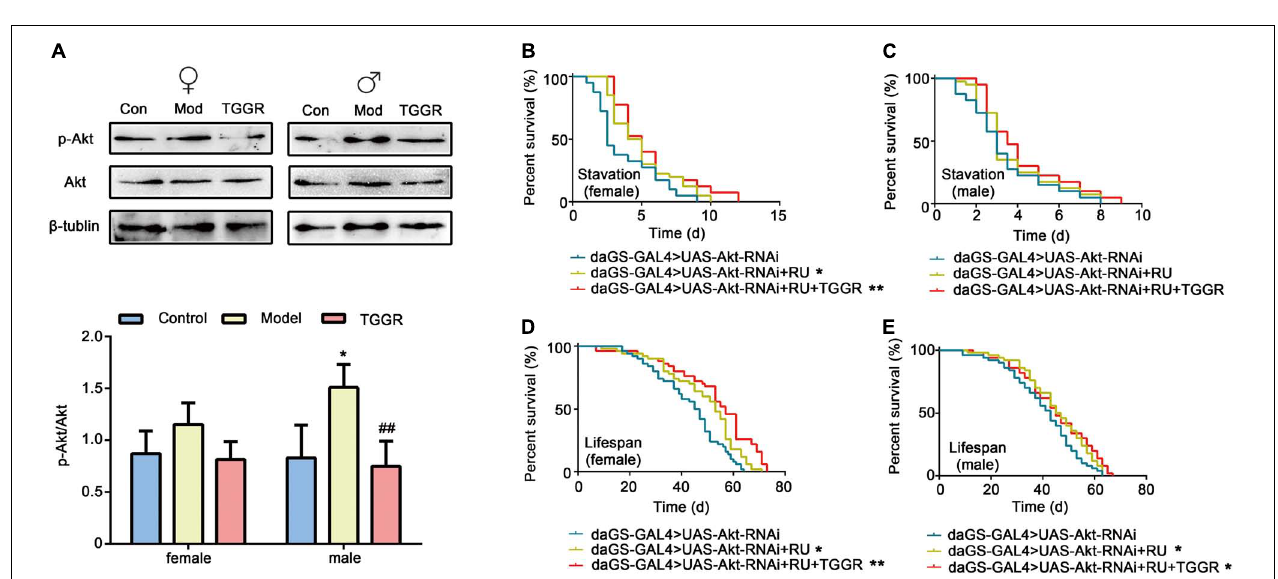
FIGURE 7 | KEGG functional pathway analysis. KEGG pathway enrichment with aging and TGGR treatment.